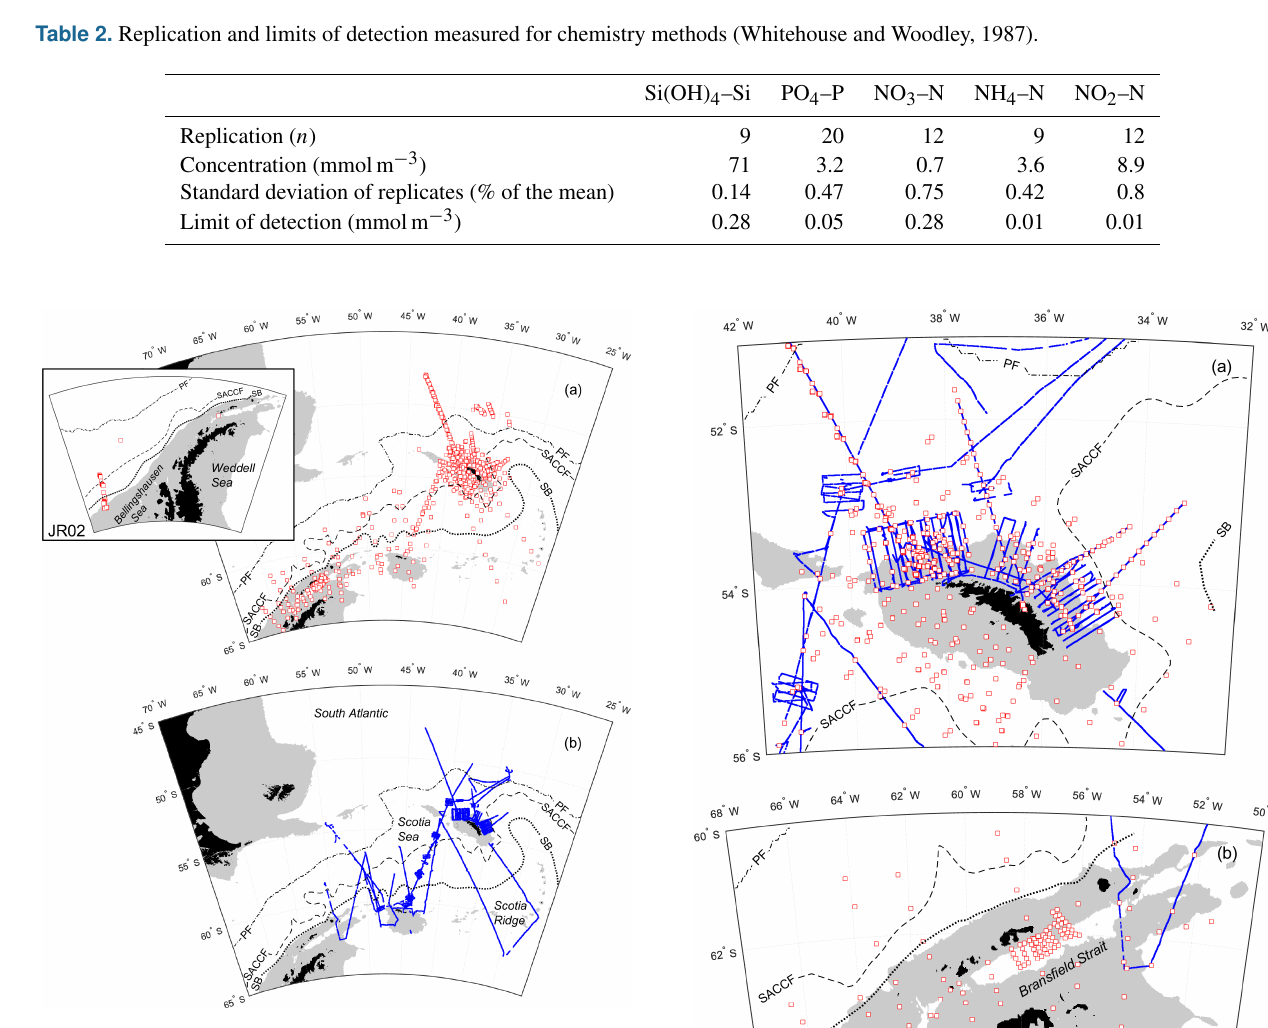
Figure 1. Sample locations of (a) CTD vertical profiles with inset to show stations sampled in the Bellingshausen Sea during cruise JR02; (b) transect data points. Southern Ocean fronts are shown in each panel: PF, Polar Front; SACCF, Southern Antarctic Circumpo- lar Current Front; SB, southern boundary of the Antarctic Circum- polar Current (Orsi et al., 1995; Moore et al., 1999; Thorpe et al., 2002; Orsi and Harris, 2019). Pale grey areas show water depths < 1000m (Amante and Eakins, 2009; NOAA National Geophysi- cal Data Center, 2009). Coastline following GSHHG, version 2.3.7 (Wessel and Smith, 2022).